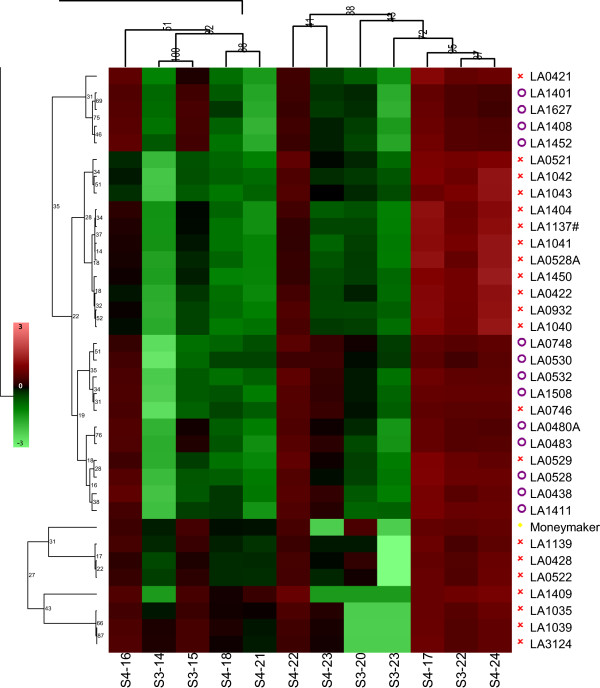
Hierarchical clustering (Pearson correlation, UPGMA), of the different acyl sucroses (columns) and the different accessions (rows).Solanum galapagense S.C. Darwin & Peralta (violet circle symbol), S. cheesmaniae L. Riley (red cross sign symbol), S. lycopersicum L cv. Moneymaker (yellow rhombus symbol). Colour key is displayed in the figure.